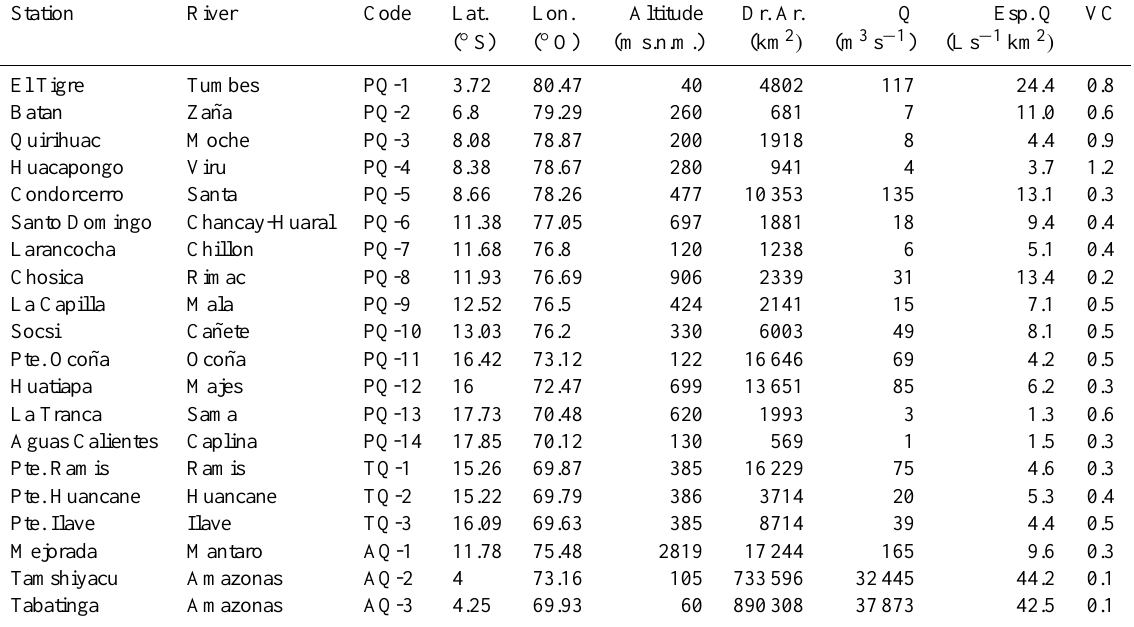
Table 1. Hydrometric stations used in this study and their main characteristics. Lat.: Latitude; Lon.: Longitude; Dr. Ar.: Drainage area; Q: Discharge; Esp. Q: Specific discharge; VC: Variation coefficient; Pte.: Bridge. PQ: rivers of the Pacific Coast region; TQ: rivers of Lake Titicaca region: AQ: rivers of the Amazonas